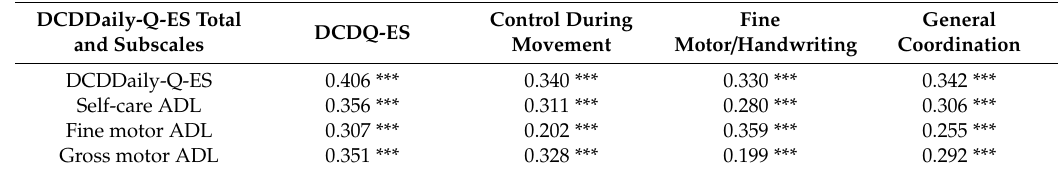
Table 5. Correlations between DCDDaily-Q-ES performance total and subscale scores and DCDQ-ES total and subscales scores ( n =